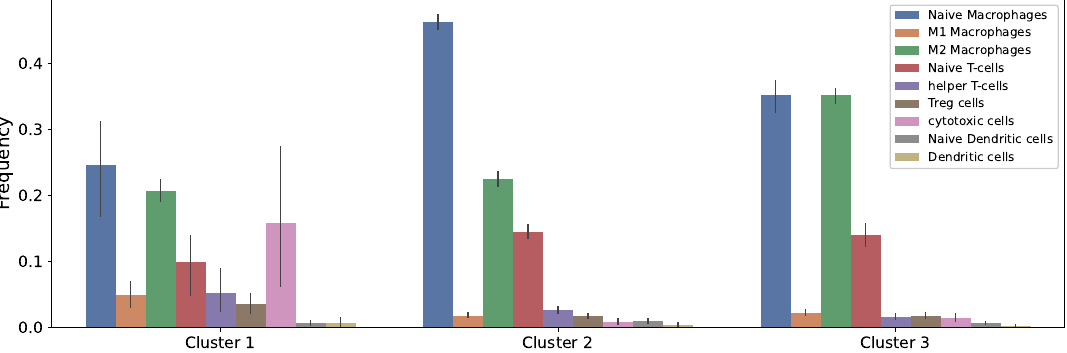
Figure 3. The immune cell fractions used in the model. Clusters were derived based on differences in 22 immune cell types of osteosarcoma